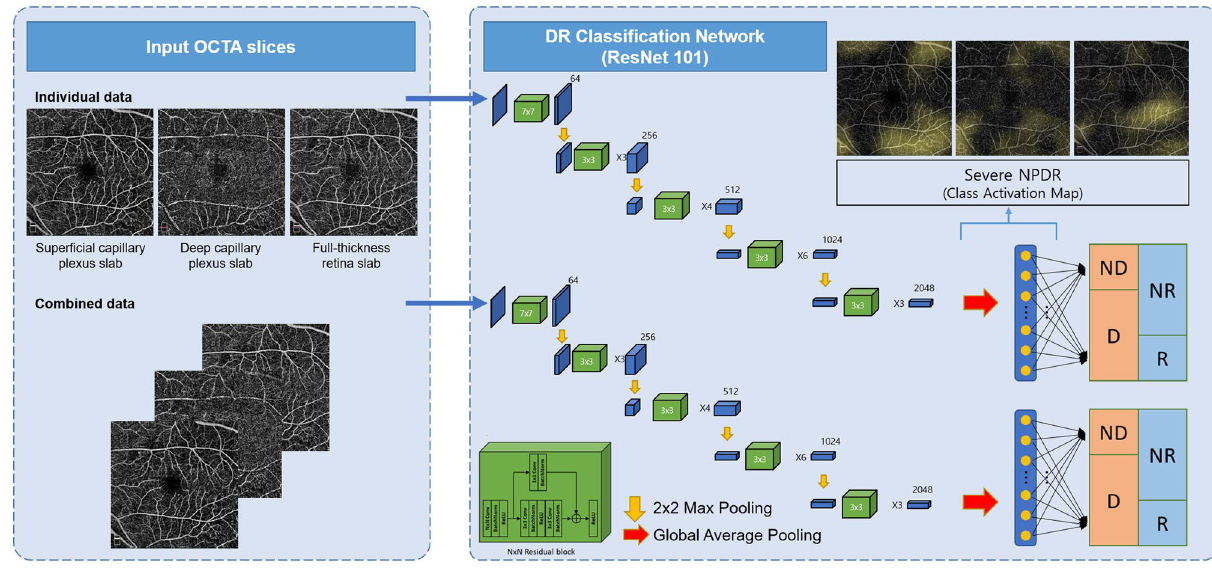
Figure 3. Convolutional neural network-based classifier for DR. This end-to-end classification task was performed to detect DR (D; mild non-proliferative DR or worse) and identify referable status (R; severe mild non-proliferative DR or worse) from OCTA images using a ResNet model. The OCTA images are passed through 16 residual blocks, while increasing the number of filters successively. After the residual blocks, each feature map is averaged in the global average pooling layer, and the probability for each stage is then obtained through a fully connected layer with softmax function. CAMs are derived from the global average pooling layer in the last part of the network to visualize the regions that significantly affect the tasks. This figure was created using Office Power Point software 2019 (https:// www. micro soft. com/ ko- kr/ micro soft- 365/ power point).